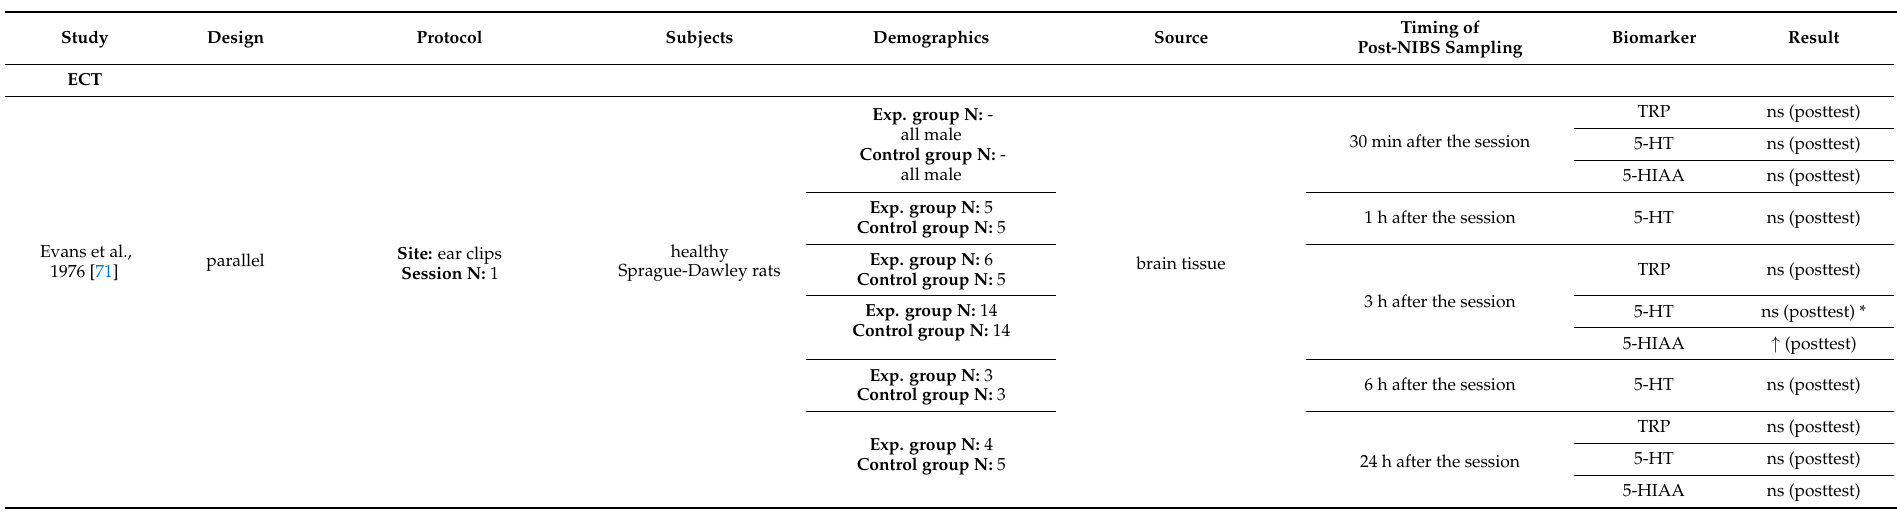
Table 3. Preclinical studies included: characteristics and individual